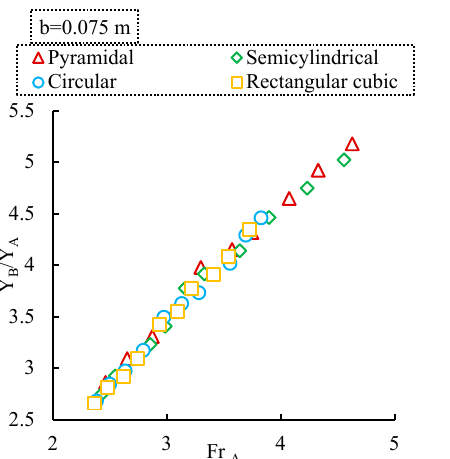
Table 3. Percentage increase in energy consumption of the sluice gate with a sill in sections A and B compared to non-sill state.